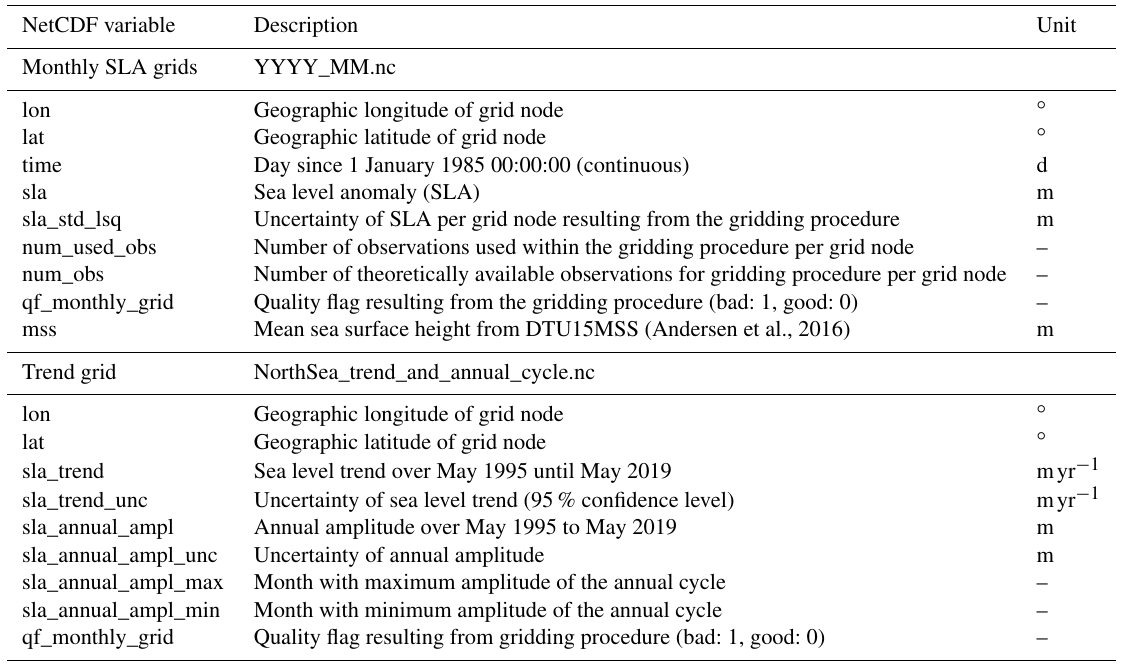
Table 2. NetCDF variables included in the dataset. NetCDF